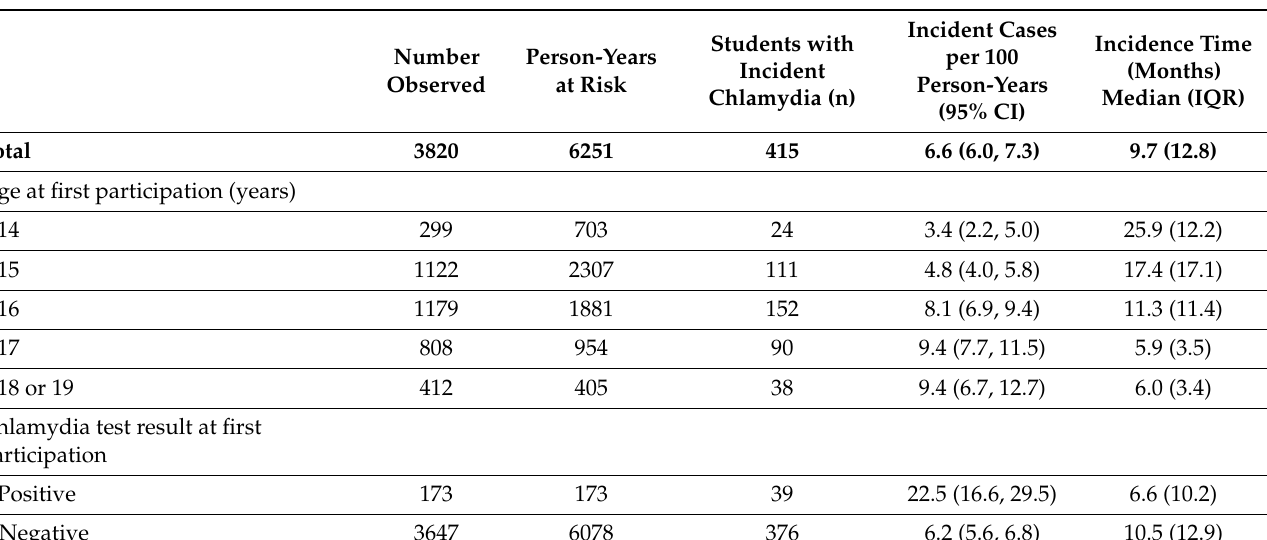
Table 1. Number of male students observed (n = 3820), person-times at risk, number of students with incident chlamydia, incidence rates, and incidence time among students who acquired incident infection (n =